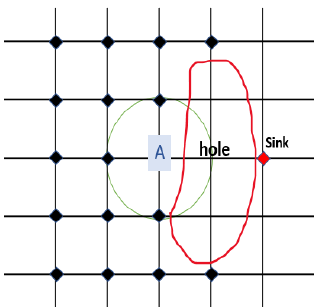
Figure 2. Local-minimum problem when a packet reaches node A and there is no direct neighbor closer to the sink than node A